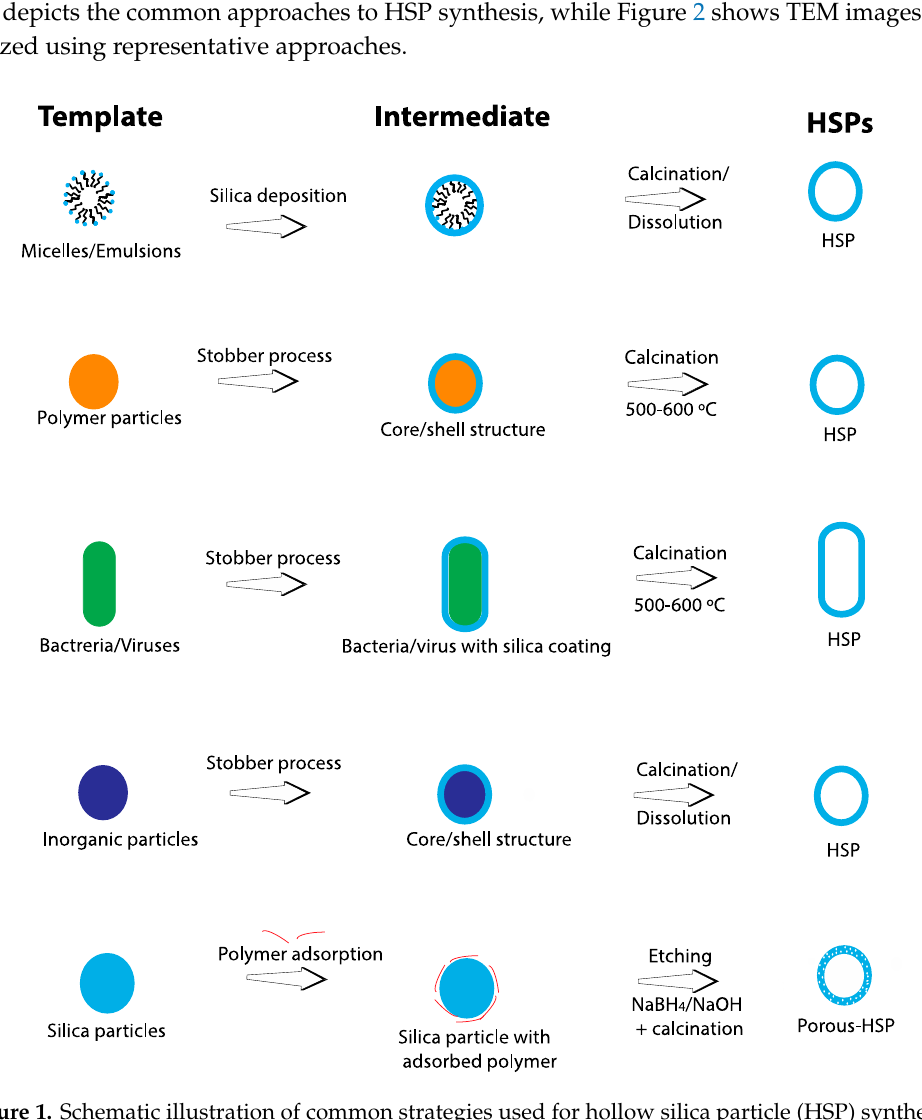
Figure 1. Schematic illustration of common strategies used for hollow silica particle (HSP)